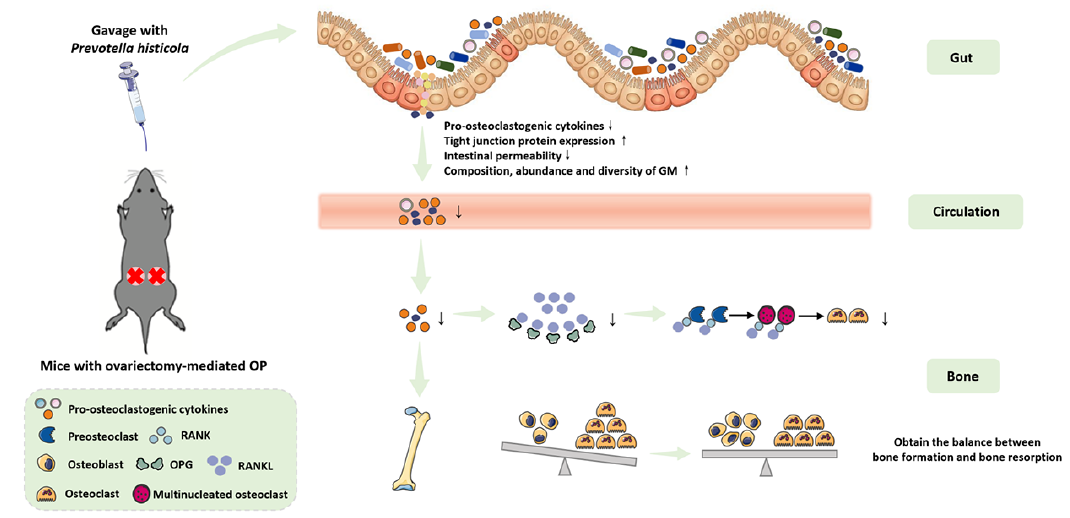
Figure 8. Relevant experimental model diagram and mechanism diagram of this study.